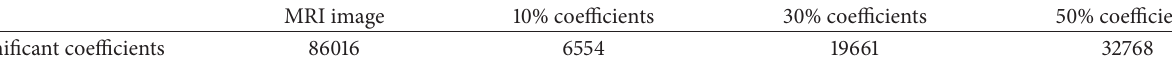
Table 1: Significant coefficients.